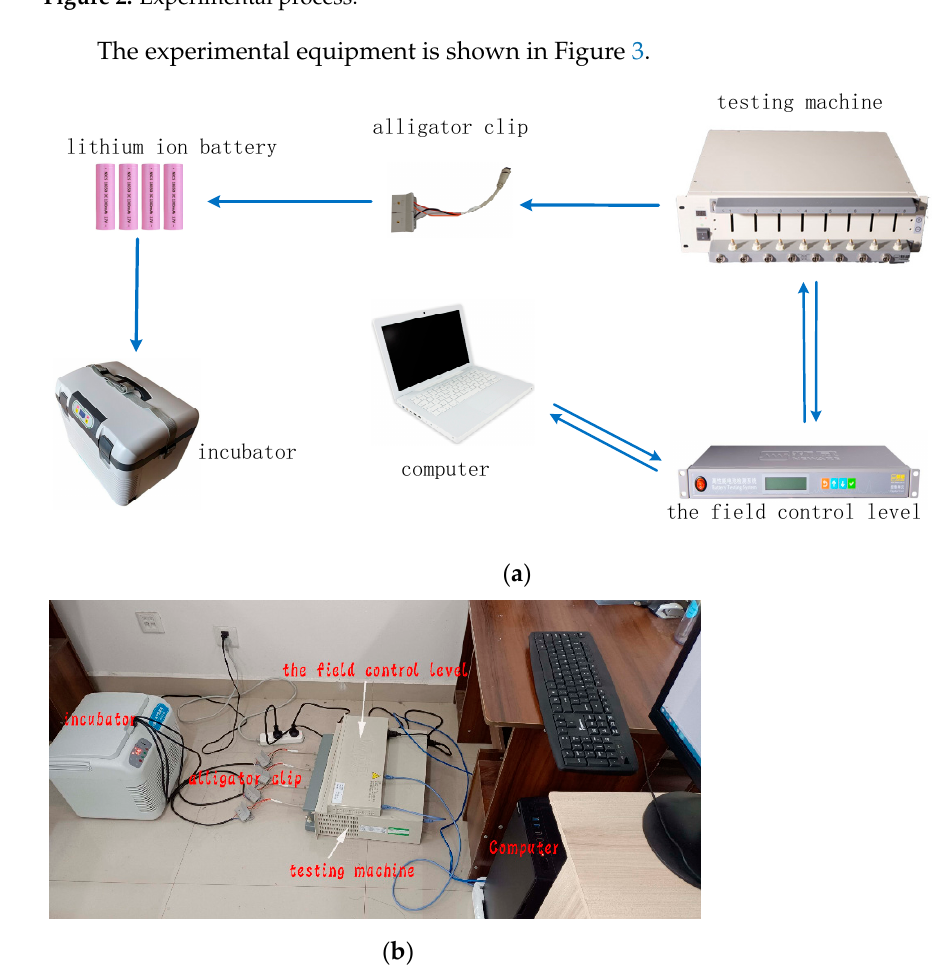
Figure 3. Experimental equipment. ( a ) experimental equipment. ( b ) equipment connection diagram.